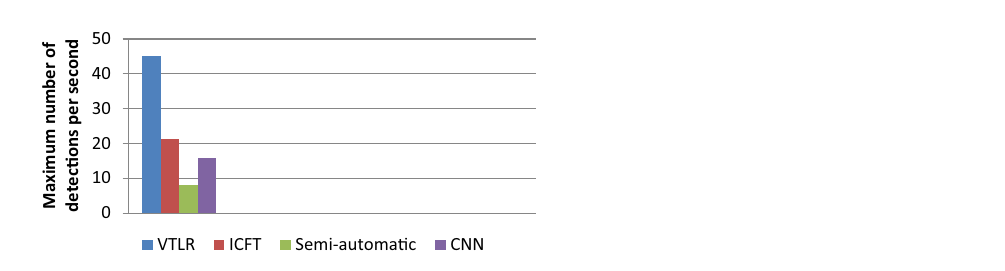
Figure 7. The average number of detections per Second.